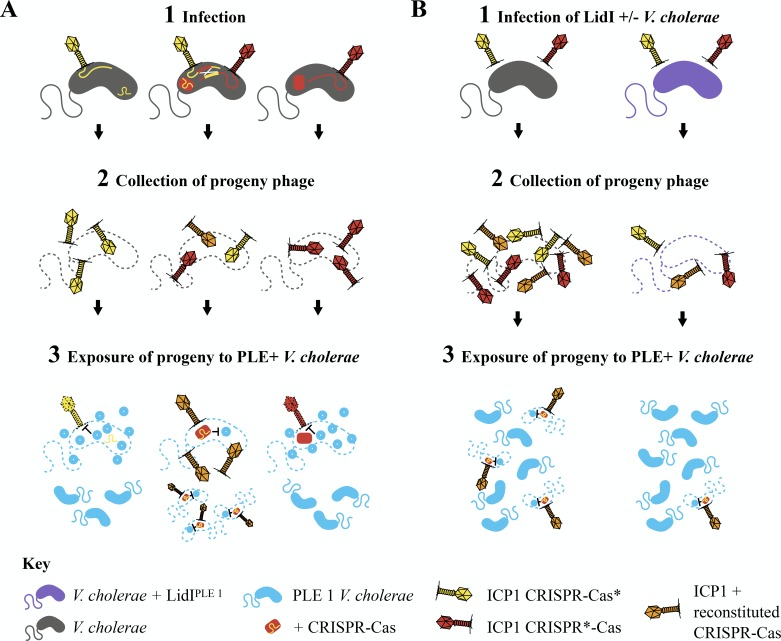
Successful recombination of progeny phage from infections as measured by phage-encoded CRISPR-Cas overcoming PLE – expanded schematic.A We engineered strains of ICP1 encoding a Type I-F CRISPR-Cas system to lack nuclease activity by deleting Cas2-3 in the CRISPR-Cas* phage (yellow) and disrupt targeting by deleting the spacers and mutating Cas1 so new spacers could not be incorporated in the CRISPR*-Cas phage (red). When these phage infect PLE (-) V. cholerae (A1), the resulting progeny phage (A2) consist of phages with the parental genotypes of the phages (yellow and red) or homologous recombination upon coinfection can produce recombinant progeny phage (orange). Some recombinant progeny phage will have reconstituted a functional CRISPR-Cas system. We can test this by exposing the progeny phage to PLE (+) V. cholerae (A3) where only phages that can defend against PLE with CRISPR-Cas will be able to form plaques (middle). B To test if LidIPLE 1 expression can impact evolution through homologous recombination, we coinfected V. cholerae with (purple) and without (grey) LidIPLE 1 with the CRISPR-Cas deficient phages (B1). After lysing the infected cultures (B2) we quantified how many progeny phage recombined to reconstitute a functional CRISPR-Cas system by exposing them to PLE (B3).